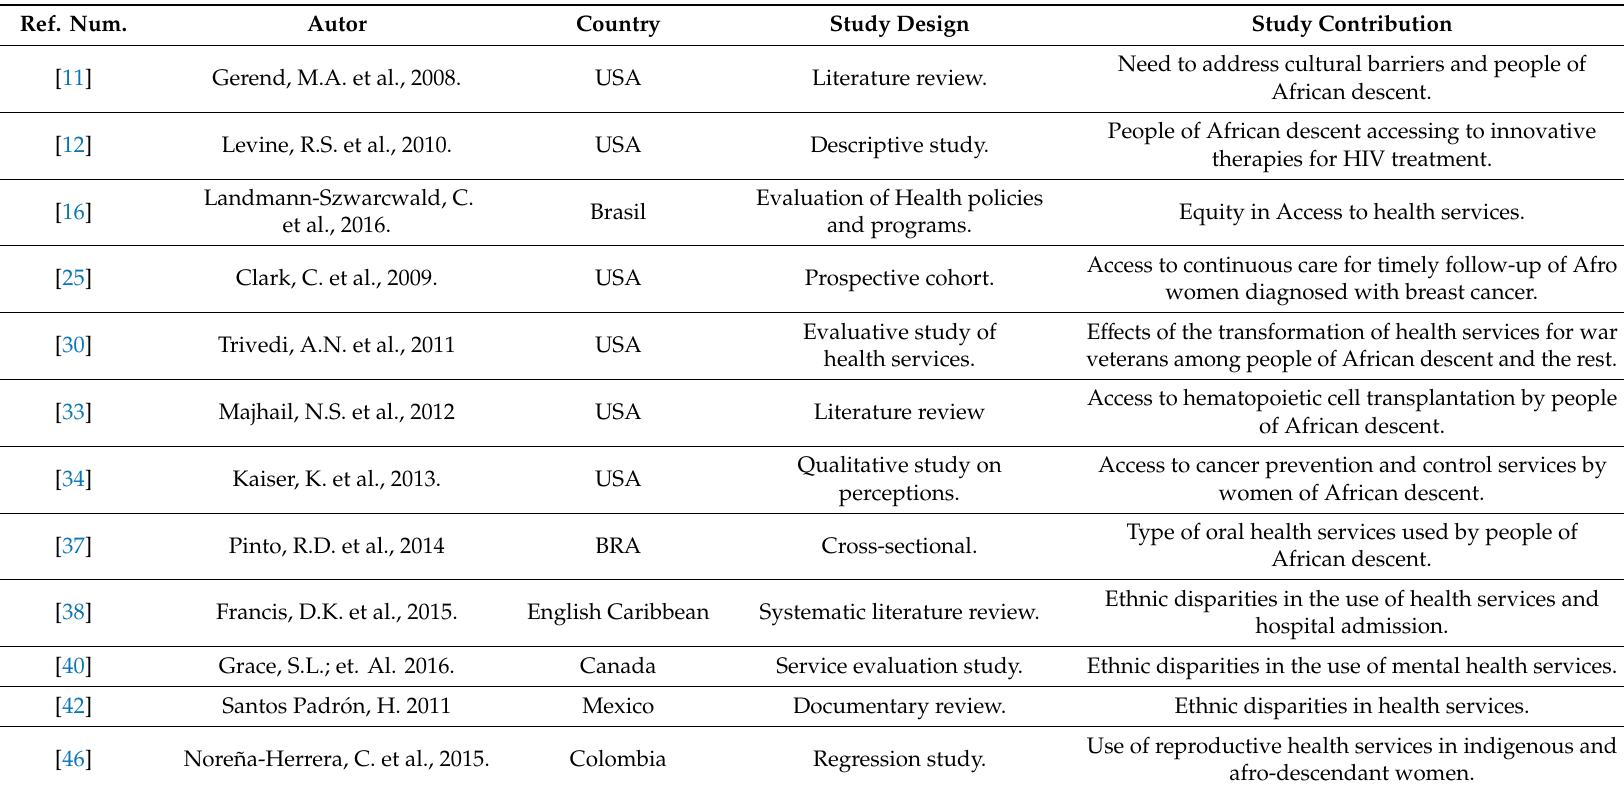
Table 8. Studies that address ethnic disparities on access and use of health services. Ref.